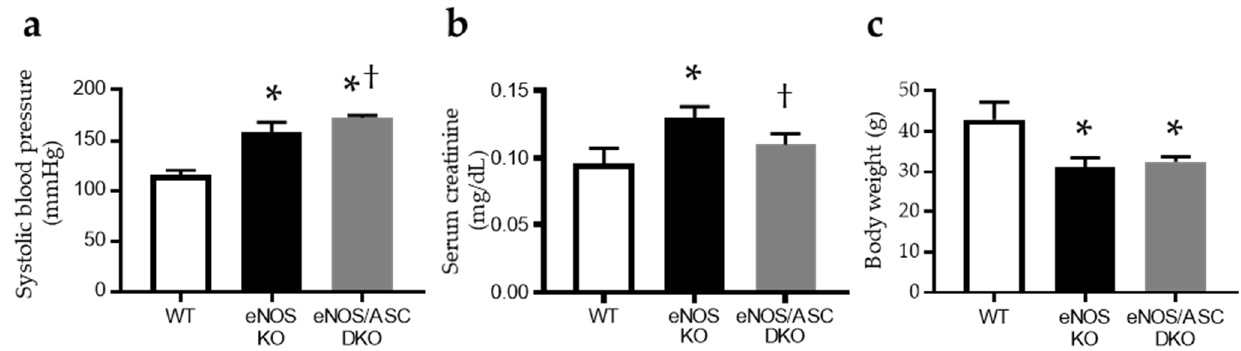
Figure 1. Evaluation of systolic blood pressure and serum creatinine. Evaluation of ( a ) systolic blood pressure, ( b ) serum creatine and ( c ) body weight. Data are expressed as means ± SD. WT, wild type ( n = 5); eNOS KO, eNOS KO mice ( n = 4); eNOS/ASC DKO, eNOS/ASC DKO mice ( n = 4). * p < 0.05 vs. WT, † < 0.05 vs. eNOS KO.